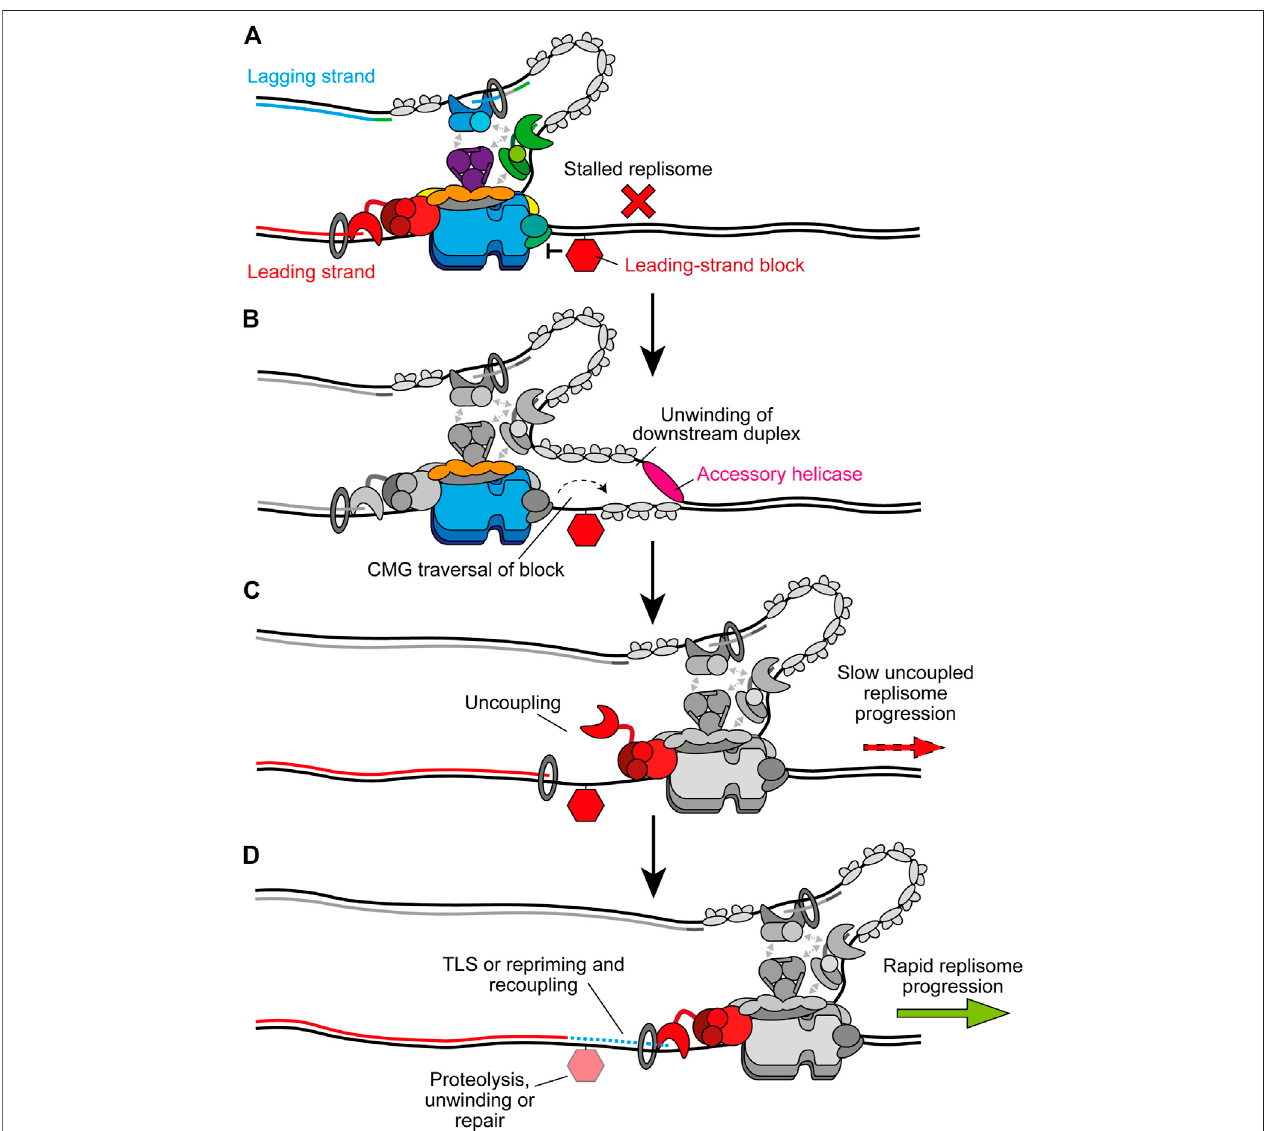
FIGURE 7 | Bypass of CMG-blocking impediments on the leading strand. (A) Bulky leading-strand impediments including DPCs, ICLs, and preformed G4s can pose a block to CMG translocation, causing stalling of the replisome. (B) CMG traversal of the impediment is aided by transient opening of the MCM2-7 ring and accessory helicases which unwind the downstream parental duplex. The speci fi c accessory helicase involved depends on the nature of the lesion, see text for details. Note that the accessory helicase may act on either the leading or lagging strand. Other replisome components are greyed out for clarity. (C) Following CMG traversal of the impediment, the replisome is uncoupled and fork progression is slow. (D) Recoupling fi rst requires resolution of the impediment and/or extension of the leading strand past the damage site. Alternatively, leading-strand synthesis may be reinitiated downstream by repriming before postreplicative repair of the damage. In the case of DPCs, proteolysis occurs before TLS and recoupling. G4s are unwound by FANCJ to promote bypass and recoupling. ICL bypass requires PrimPol- mediated repriming before recoupling, leaving an X-shaped structure for postreplicative repair. Upon recoupling, rapid fork rates resume. Recoupling is indicated by a blue dotted line and Pol ε synthesis is shown in